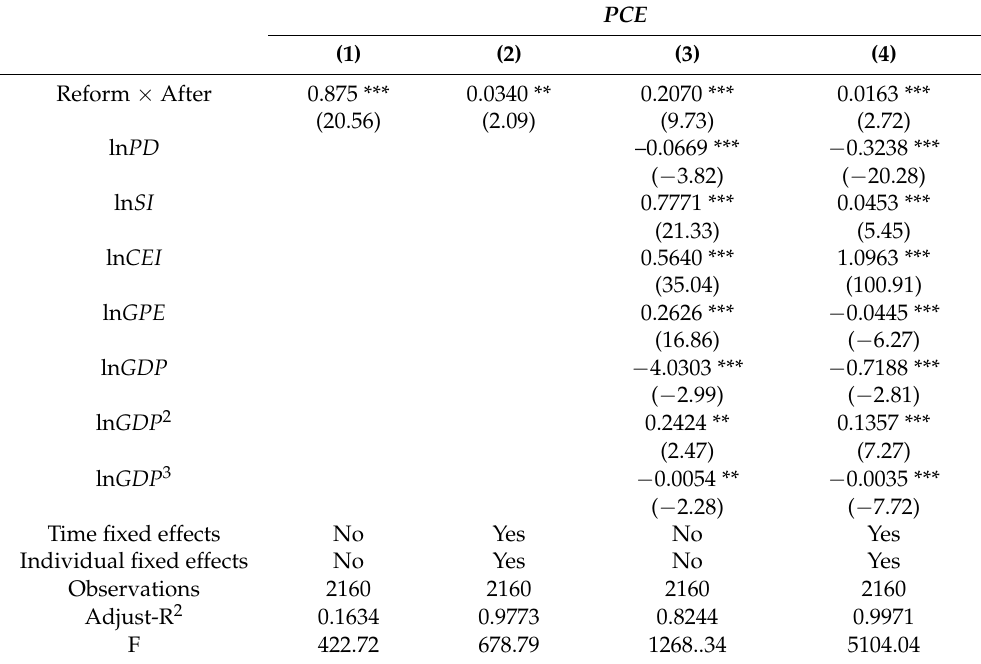
Table 3. Baseline regression results of the